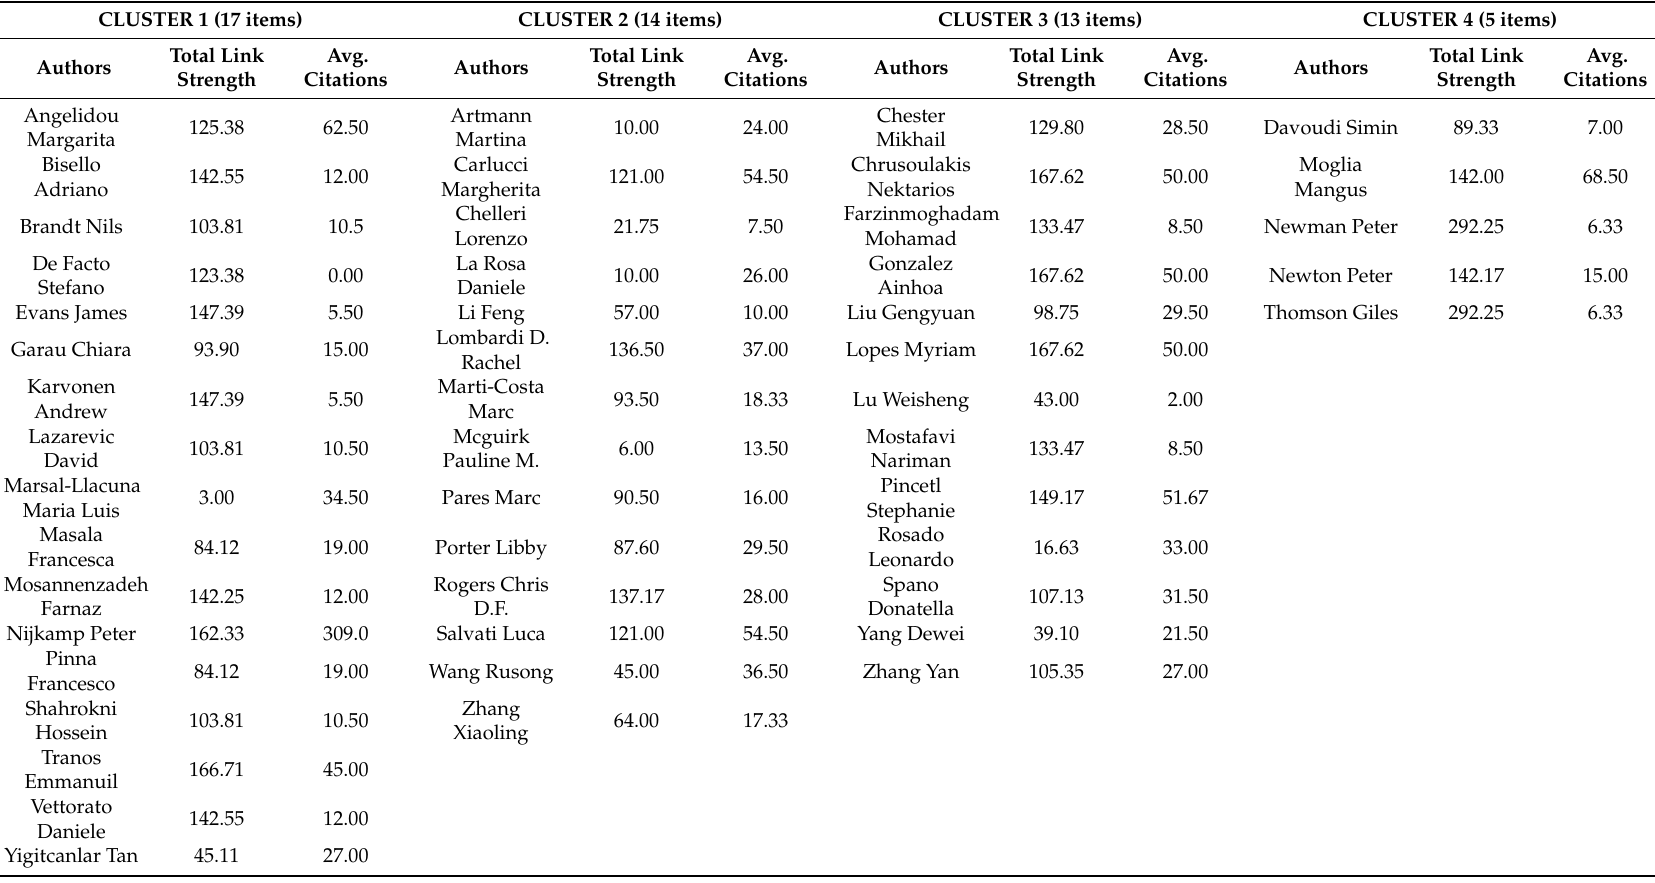
Table A2. Average citations and total link strength of authors per cluster based on bibliographic coupling